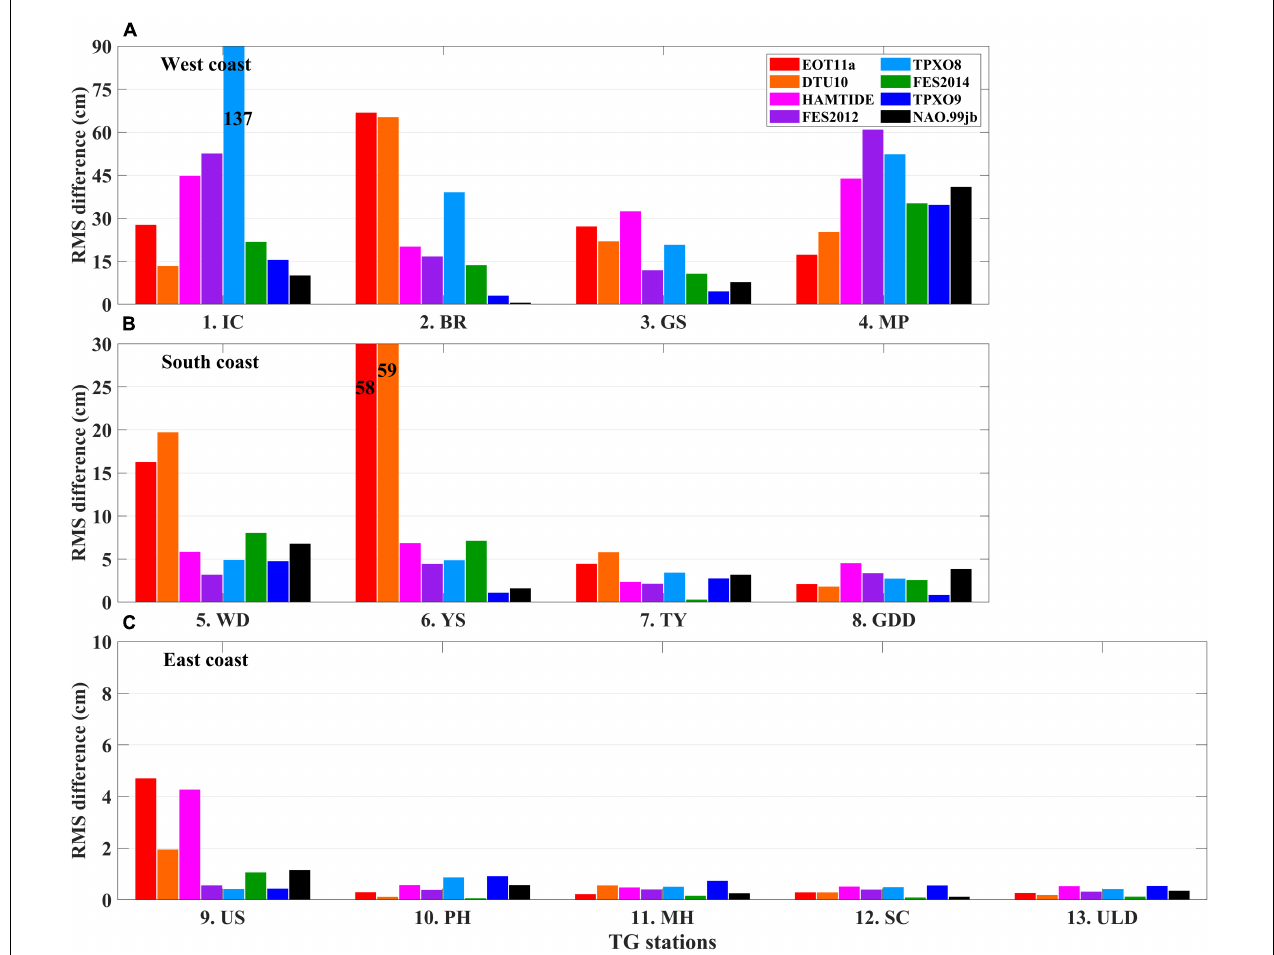
FIGURE 4 | Column chart of root-mean-squared (RMS) difference (cm) between observed and modeled M 2 tidal constants (see texts for details) for TG stations along (A) west, (B) south, and (C) east coasts of KP (locations are remarked in Figure 1 ). Observed and modeled M 2 tidal constants obtained by harmonic analysis of observed SLA and eight ocean tide models, respectively, are also shown (colors correspond to legend in upper-right corner). Numbers on columns for IC (TG station number 1) and YS (TG station number 6) denote RMS differences exceeding y-axis